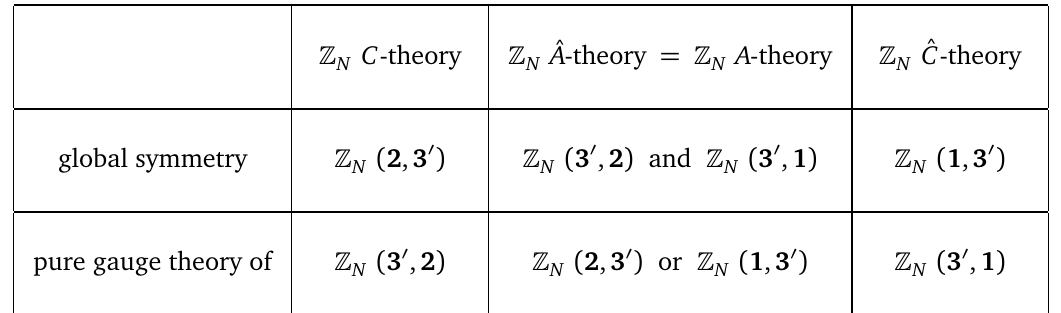
Table 7: Global and gauge symmetries of three (cid:90) gauge theories. The (cid:90) symme- N N ) of the temporal and spatial tries are labeled by the S representations ( R , R 4 time space A and currents for their U ( 1 ) versions. See Table 1 of [ 5 ] for more detail. The (cid:90) N ˆ A theories are dual to each other, and they are the continuum limit of the X-cube ˆ C -theory is the continuum limit of the plaquette Ising model model [ 5 ] . The (cid:90) N ( 1 , 3 (cid:48) ) dipole global symmetry is the continuum version in [ 9 ] . Furthermore, the (cid:90) N of the planar subsystem symmetry of the plaquette Ising model. We did not include all the global symmetries of these models in the table above.